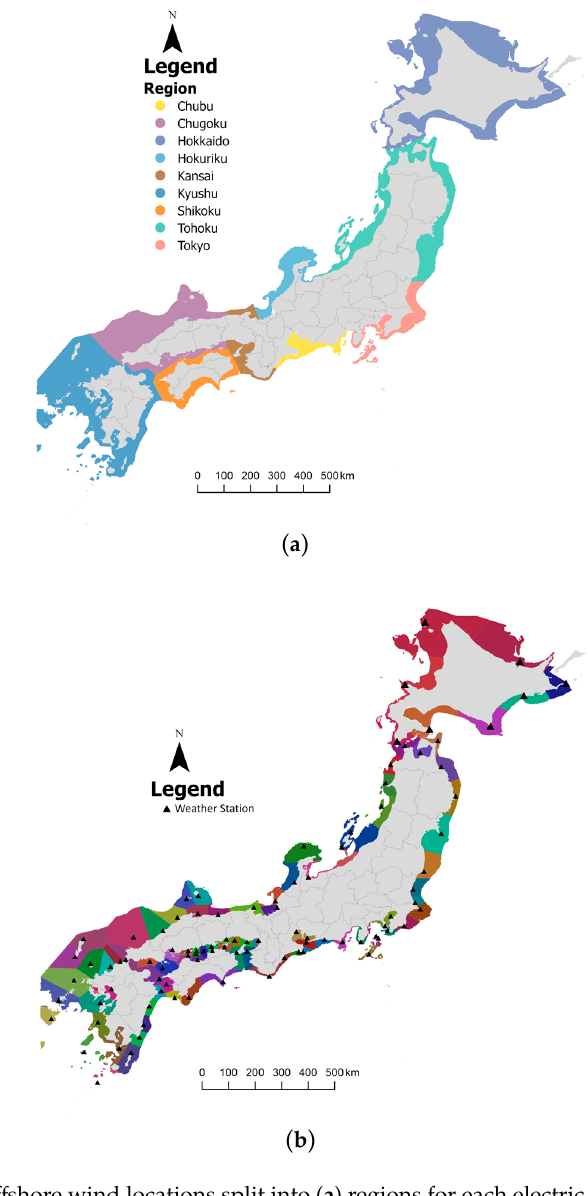
Figure 4. Suitable offshore wind locations split into ( a ) regions for each electric power company and ( b ) areas for each available weather station, where each color represents a different area.